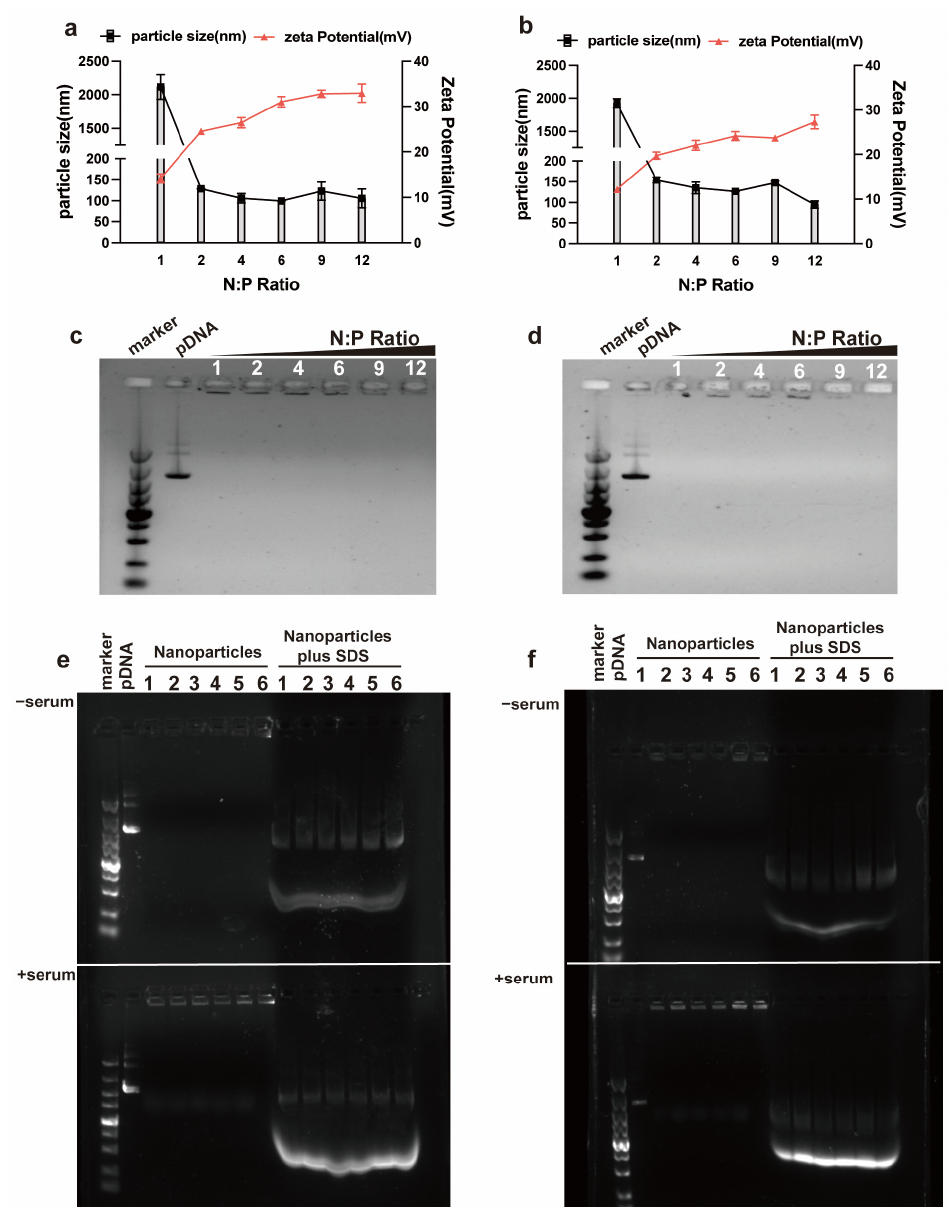
Figure 1. Characterization of RALA-E/pDNA complexes. ( a , b ) Particle size and Zeta potential of RALA/pDNA ( a ) and RALA-E/pDNA ( b ) complexes; ( c , d ) Gel retardation assay of RALA/pDNA ( c ) and RALA-E/pDNA ( d ) complexes; ( e , f ) Serum stability assay of RALA/pDNA ( e ) and RALA-E/pDNA ( f ) complexes. The numbers (1, 2, 4, 6, 9, 12, or 1, 2, 3, 4, 5, 6) in this figure denote N:P ratios.